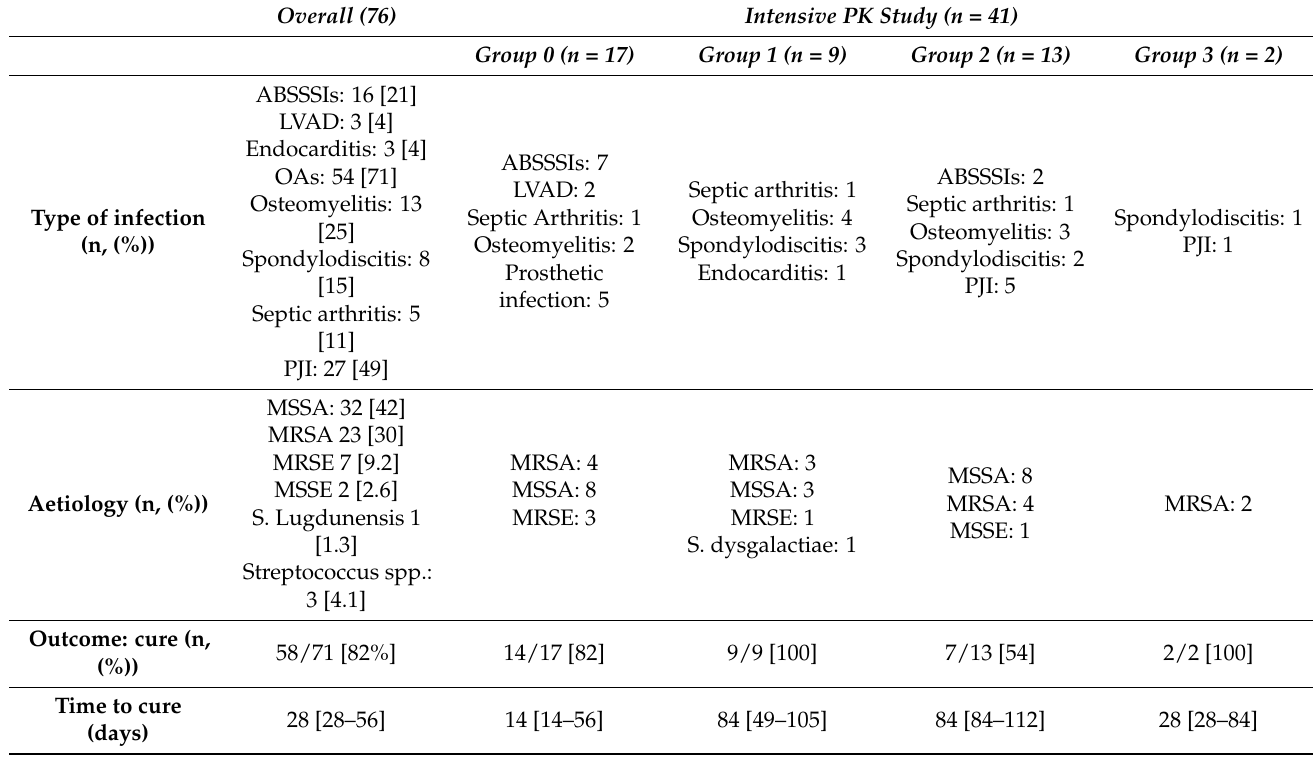
Table 2. Main clinical and microbiological characteristics and